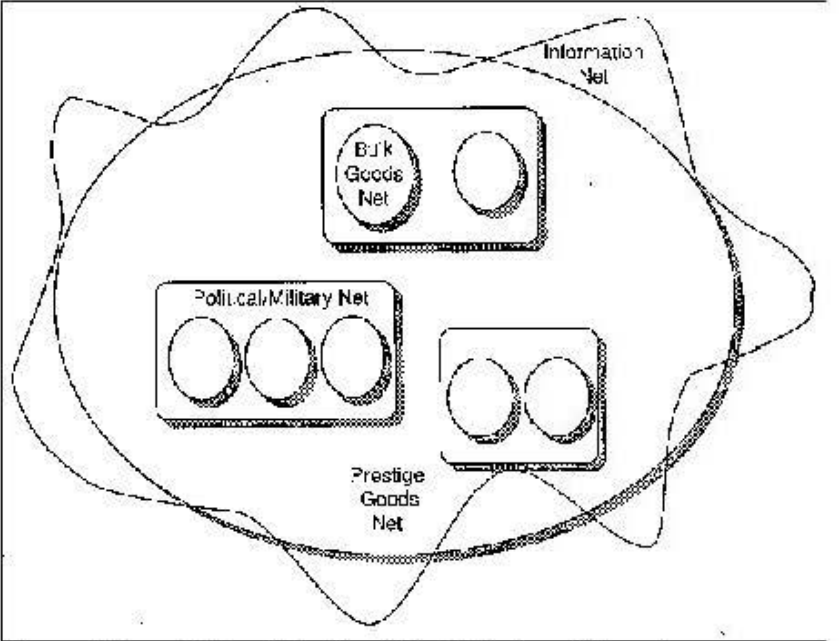
figure I. Boundaries of the ·four World-System